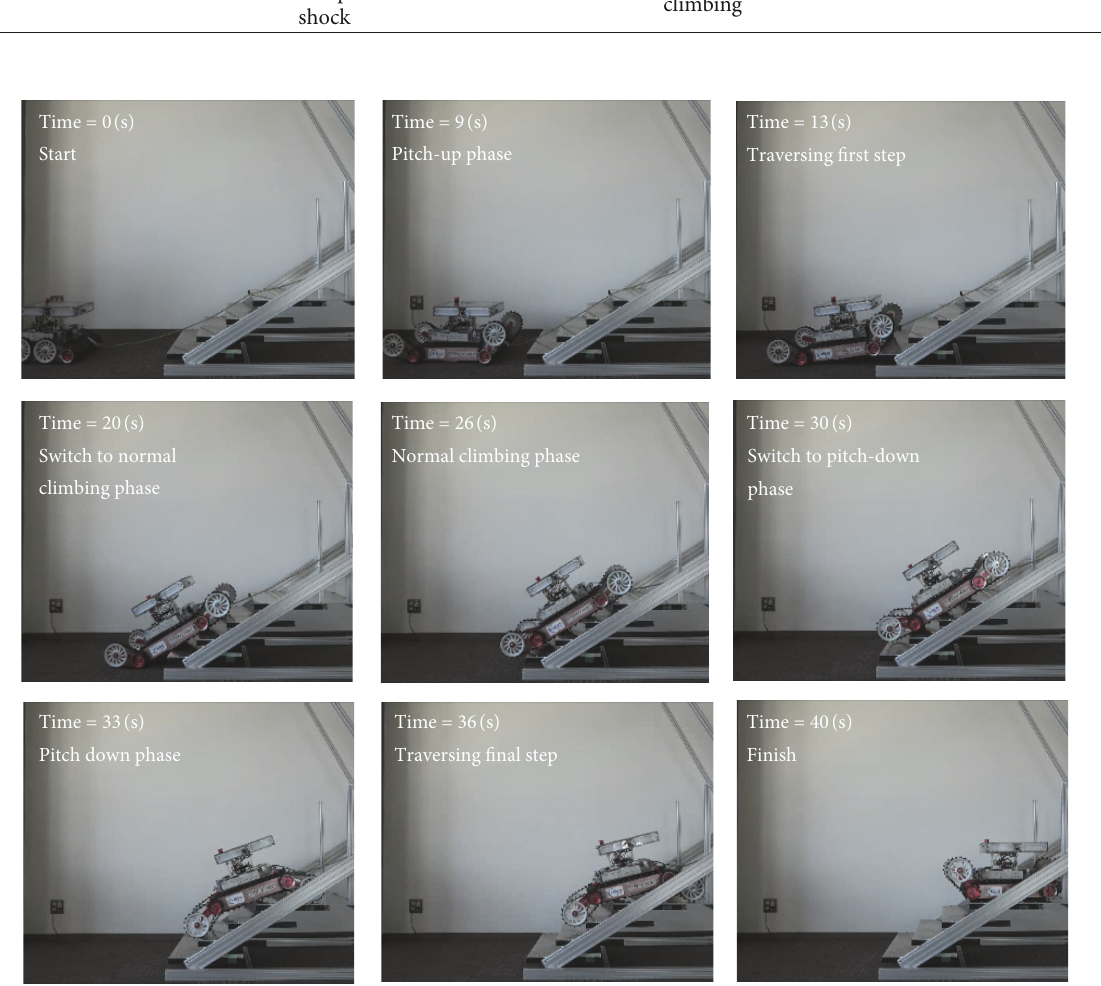
Figure 18: Climbing-up behavior for case 𝜃 𝑠 = 30 ∘ , 𝑝 = 200